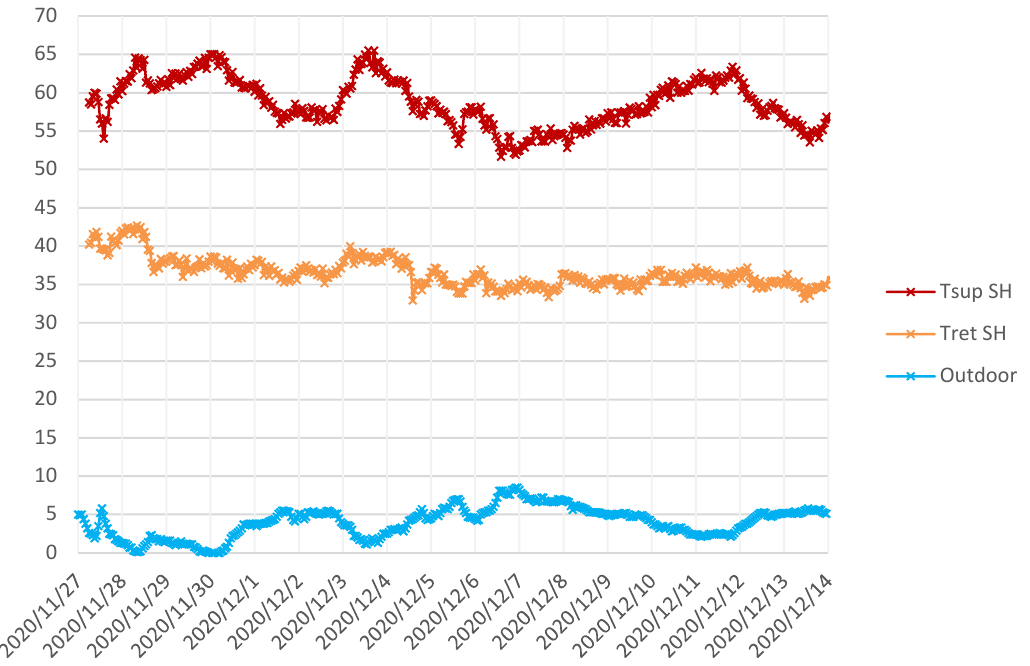
Figure 14. Hourly measurements of supply and return temperatures in the space heating system during the test of prototype 2.